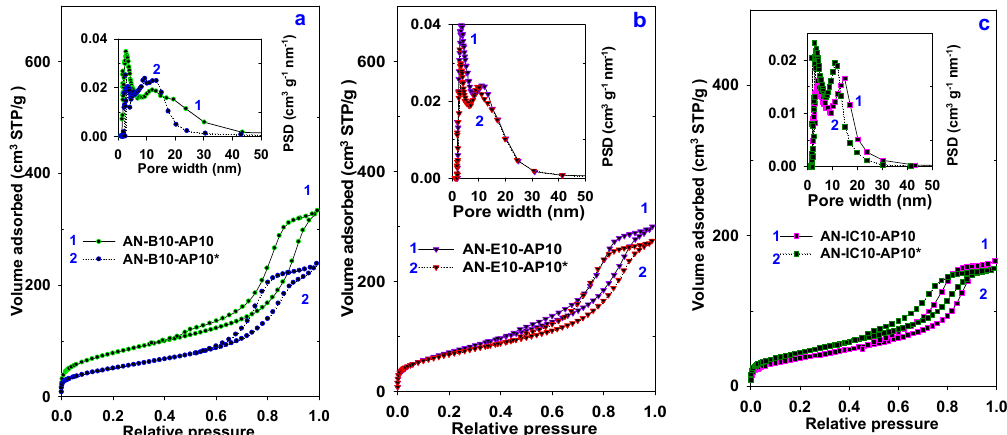
Figure 5. N 2 adsorption isotherms and their corresponding PSD curves (insets) for extracted (AN-B10-AP10 (left panel a ), AN-E10-AP10 (middle panel b ), and AN-IC10-AP10 (right panel c )), and extracted calcined (AN-B10-AP10*(left panel a ), AN-E10-AP10*(middle panel b ), and AN-IC10-AP10*(right panel c )) samples. Note that AN and AP refer to aluminum nitrate and aminopropyl, respectively.